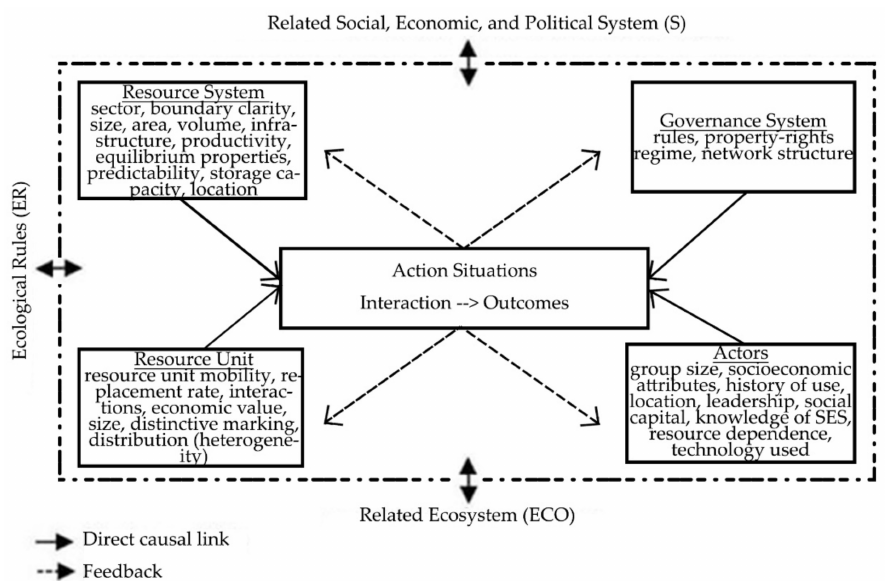
Figure 1. Second- and third-tier social–ecological system (SES) attributes. Adapted from Ostrom and Cox [12].